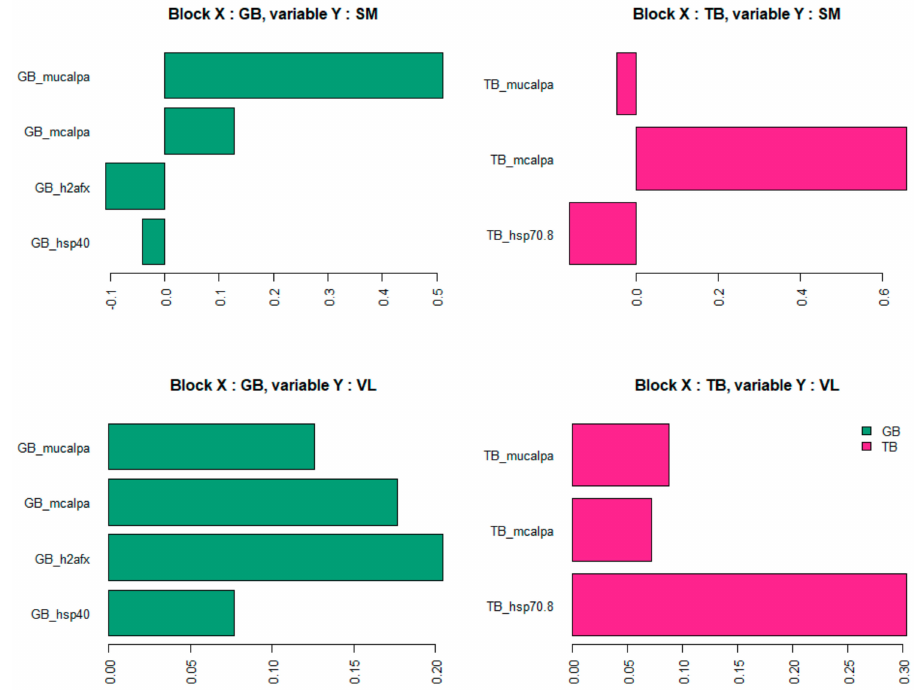
Figure 8. Coe ffi cients associated with each biomarker in tenderness prediction models (representing the relative importance of each selected